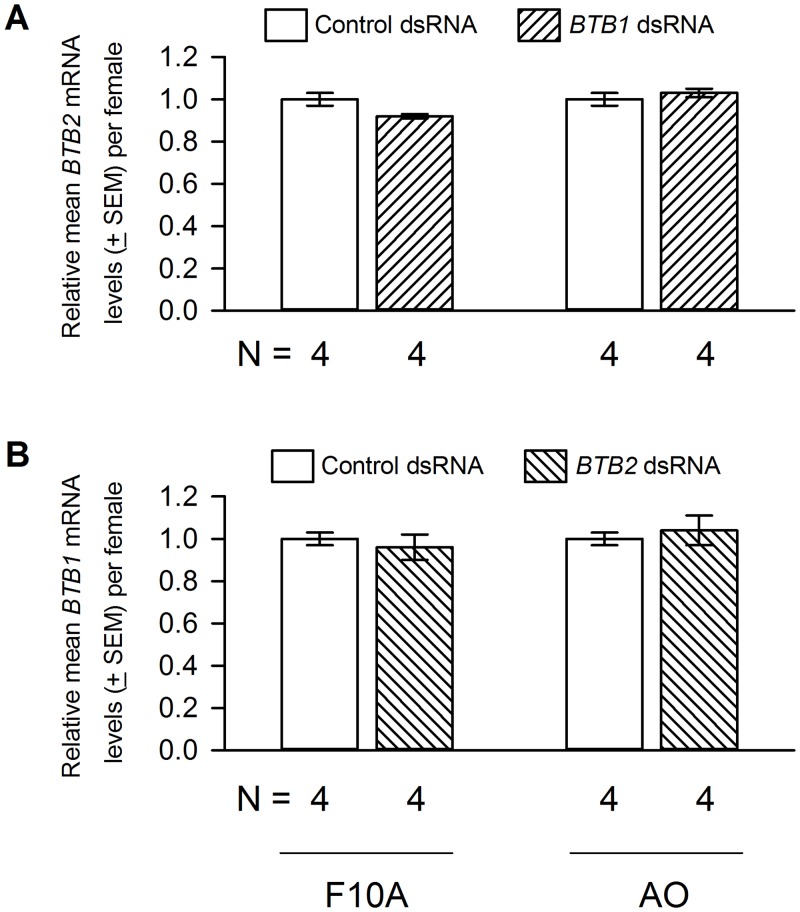
The effects of BTB1 and BTB2 dsRNA deliveries on the mRNA levels of BTB2 and BTB1, respectively.
BTB1
(A) and BTB2
(B) dsRNA deliveries did not alter the mRNA levels of BTB2 and BTB1, respectively, in either F10A or AO females. Student’s t test results for the relative BTB2 (or BTB1) mRNA levels in F10A (or AO) mites that received control or BTB1 (or BTB2) dsRNA are P > 0.1, 2-tailed t test. The BTB2 (or BTB1) mRNA levels in control females were scaled to 1.